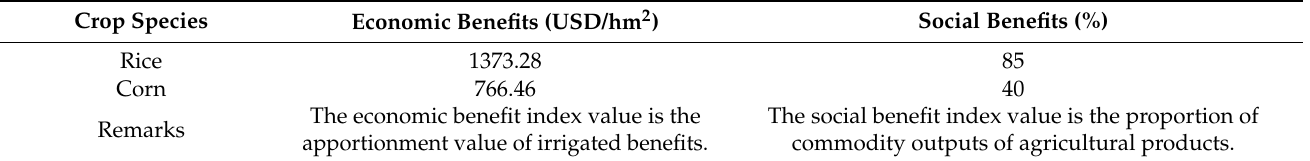
Table 3. Characteristic values of the quantitative indexes.